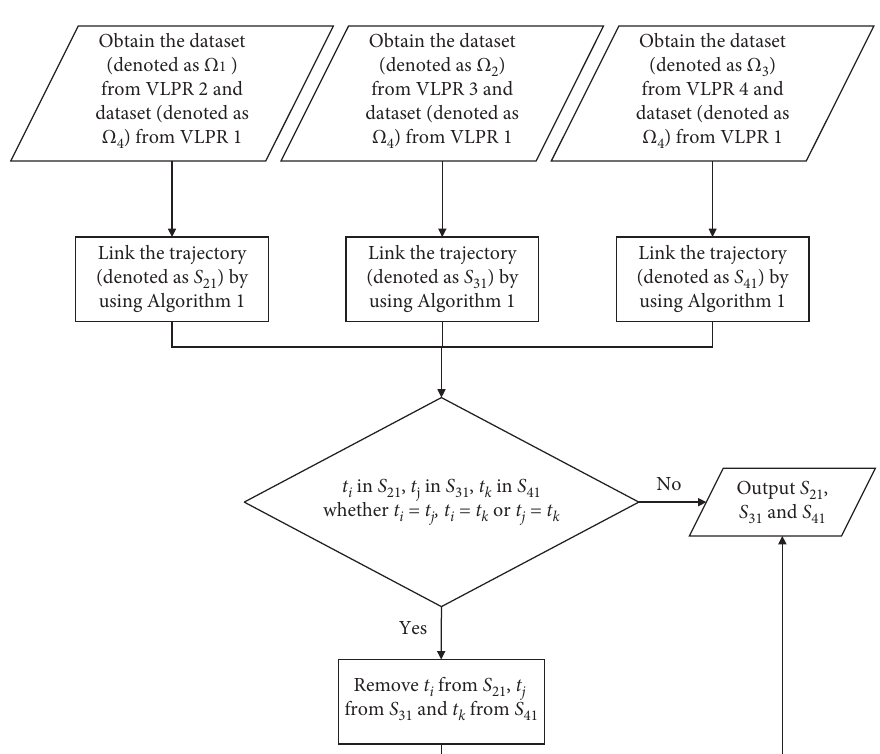
Figure 4: The linking procedure for Case